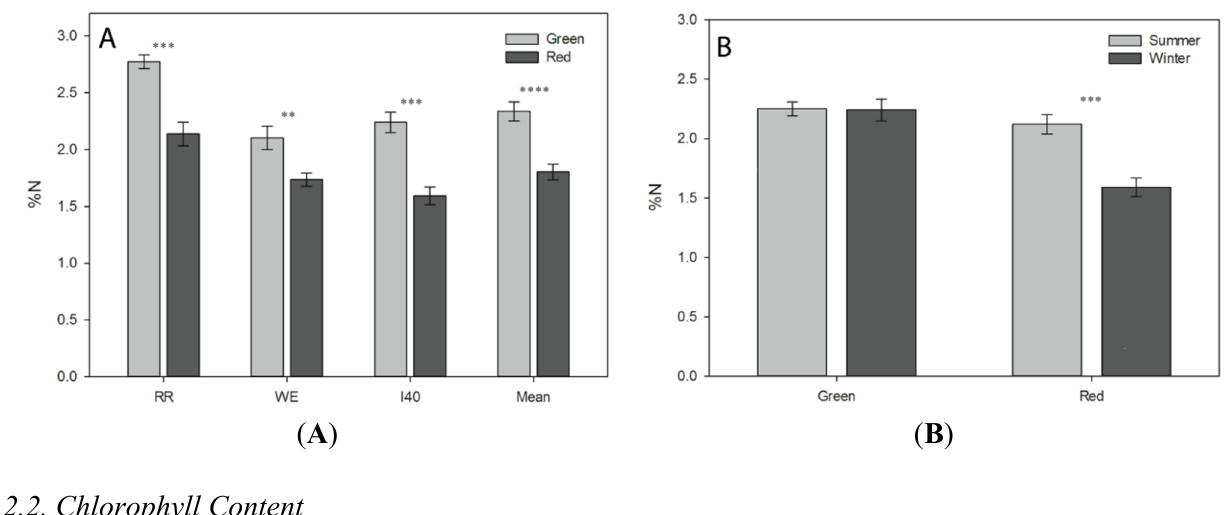
Figure 1. Mean nitrogen content in red versus green L. japonica leaves. ( A ) Winter mean percent nitrogen content (±SE) at RR (n green = 5, n red = 5), WE (n green = 7, n red = 6), I40 (n green = 6, n red = 6), and combined means from all sites. Significant differences between red and green leaves denoted by asterisks (* p < 0.05; ** p < 0.01, *** p < 0.001, and **** p < 0.0001); ( B ) Mean percent leaf nitrogen (±SE) from leaf tissues collected at I40 during summer (n winter-green = 6, n winter-red = 6) and winter (n green = 6, n red =